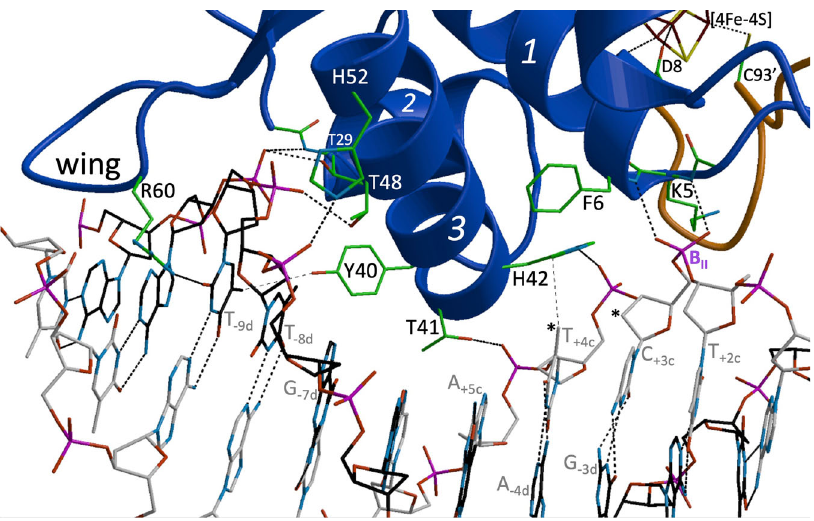
Fig. 3 Close up view of the Sc NsrR/ hmpA1 interface. C α traces of the A and B subunits are depicted in gold and blue, respectively; ribbons are used to depict α -helices. DNA double helix bonds and contacting NsrR residues are represented with sticks. Hydrogen bonds and salt bridges are indicated with thick dashed lines; two van der Waals contacts are shown as thin dashed lines. The asterisks (*) label the T + 4c -methyl group and the C + 3c -C2 ’ atom. Atom color codes: Fe brown-red, S yellow, P pink, O red, N blue and C green, black or gray. For stereo versions of this fi gure see Fig. S3a,